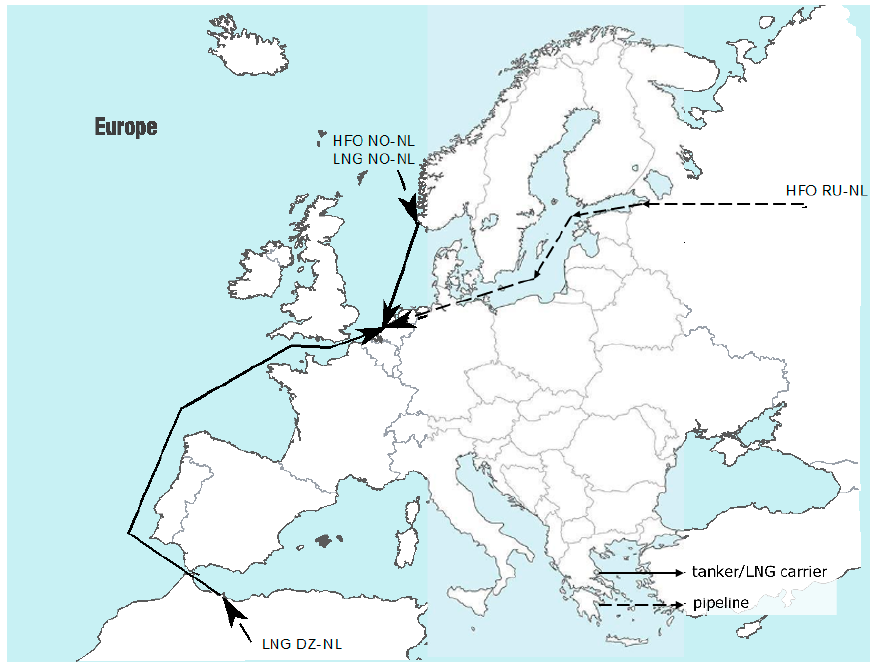
Figure 1. System boundaries.